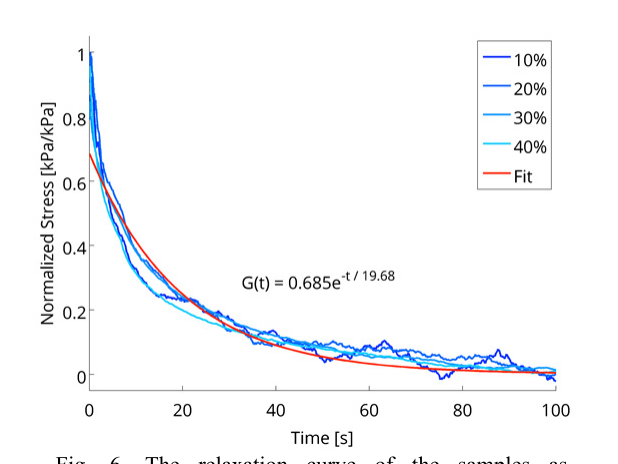
Fig. 6. The relaxation curve of the samples as represented by normalized stress vs. time plot. The stress has been normalized through the full range of values by finding the ratio of the values to the peak value observed at the initial point of relaxation. The graph highlights the relaxation mechanism of tofu observed is essentially the same in all samples.